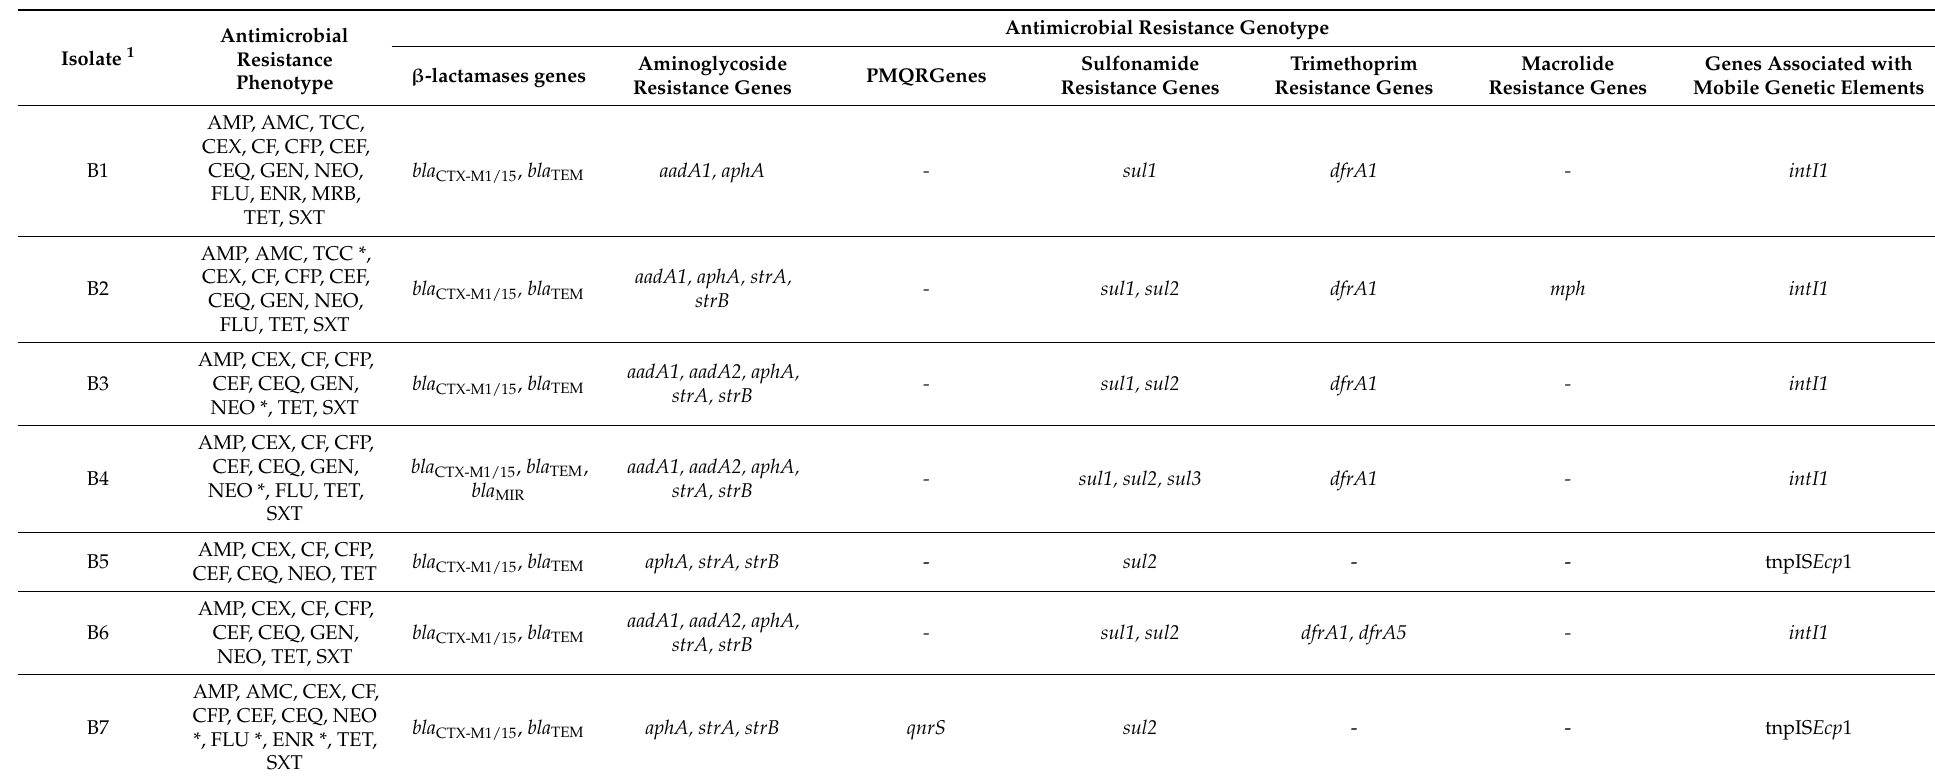
Table 1. Antimicrobial resistance phenotype and genotype of the ESBL-producing E. coli